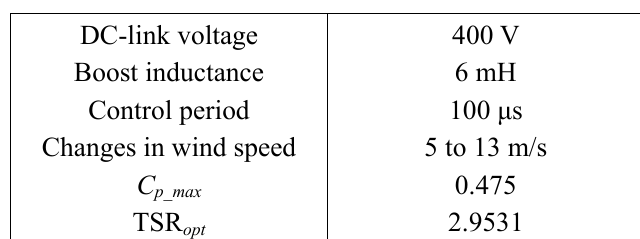
Table 1. Simulation parameters.